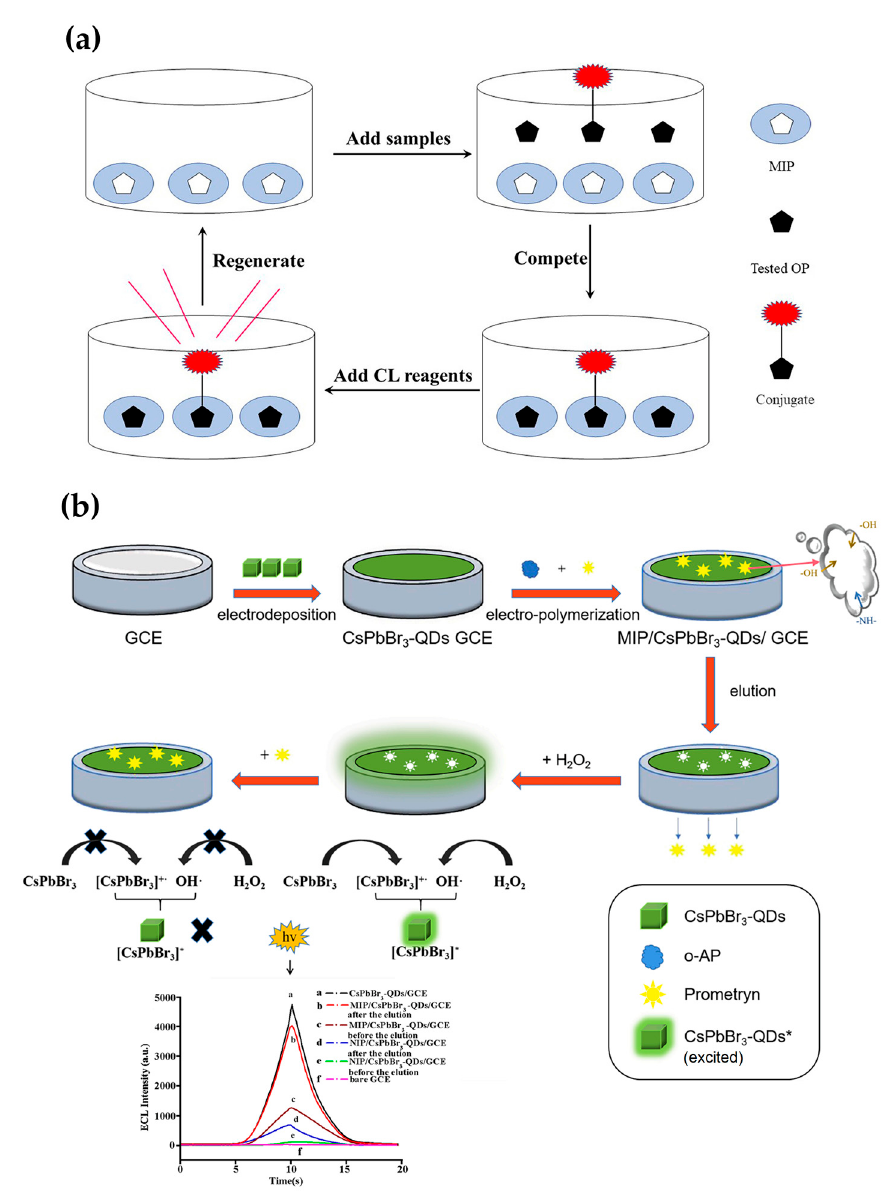
Figure 6. ( a ) Principle of MIP-based microtitration CL sensors in organophosphorus detection [16]. ( b ) Preparation of ultrasensitive ECL sensor for prometryn determination [48]. Copyright 2022 Elsevier (Amsterdam, The Netherlands).